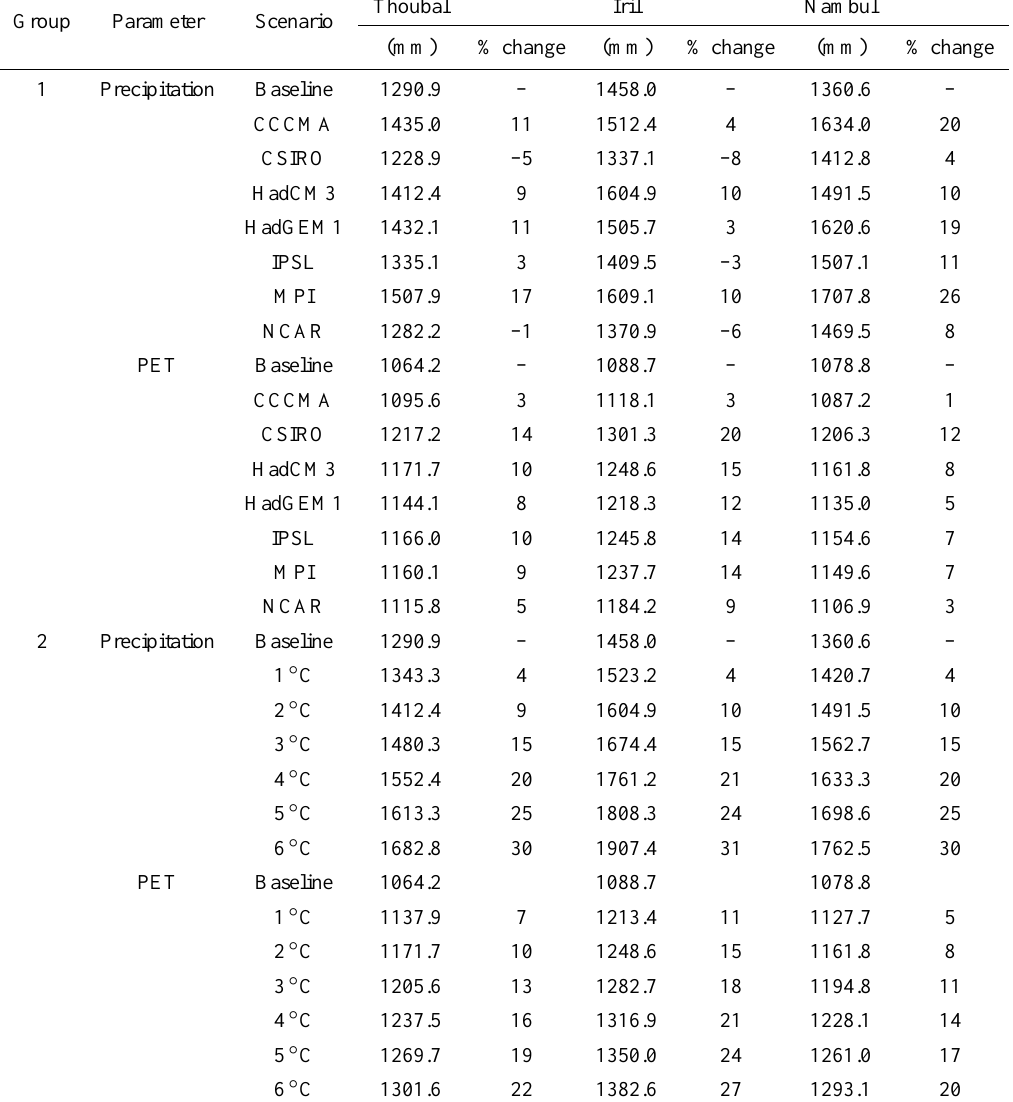
Table 5. Changes in meteorological precipitation and PET due to the climate change